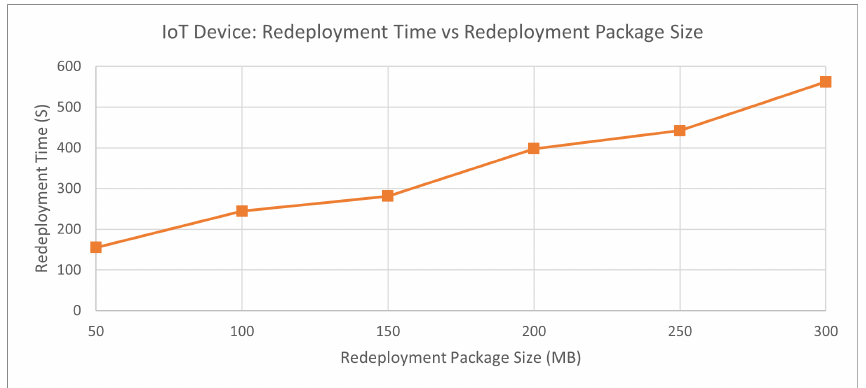
Figure 6. Redeployment Time vs. Redeployment Package Size.